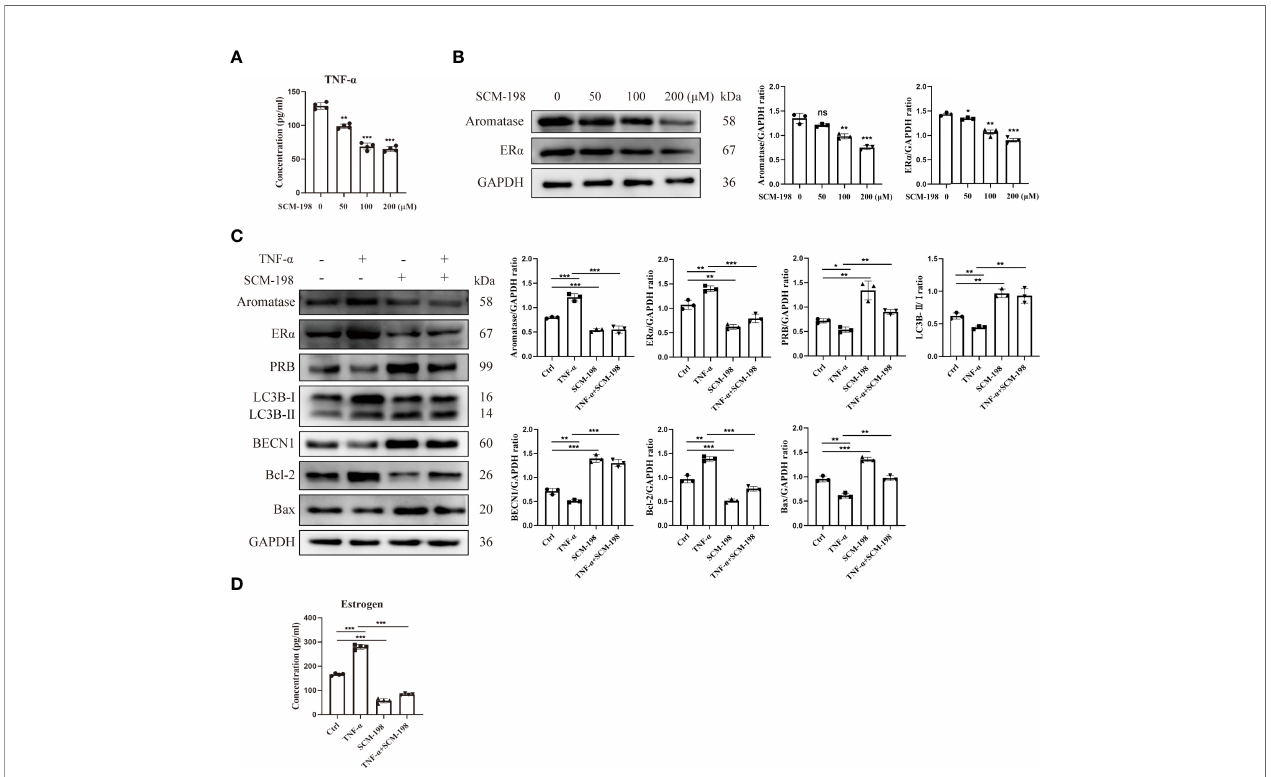
FIGURE 6 | The proapoptotic effects of SCM-198 are brought about by downregulating the aromatase-estrogen pathway via the inhibition of TNF- a . (A) ELISA was utilized to detect the TNF- a concentration of eESCs treated with different doses of SCM-198 (n = 4). (B) The protein expressions of aromatase and ER a in eESCs treated with different doses of SCM-198 were measured via Western blotting (n = 3). (C, D) After treatment with TNF- a (10 ng/ml), SCM-198 (200 µM), or TNF- a +SCM-198 (10 ng/ml, 200 µM), the expressions of aromatase, ER a , PRB, LC3B-II/I, BECN1, Bcl-2, and Bax were analyzed via Western blotting (n = 3) (C) , and the concentration of estrogen was detected via ELISA (n = 4) (D) . Continuous data are presented as the mean ± SD (* P < 0.05, ** P < 0.01, and *** P < 0.001; ns, not signi fi